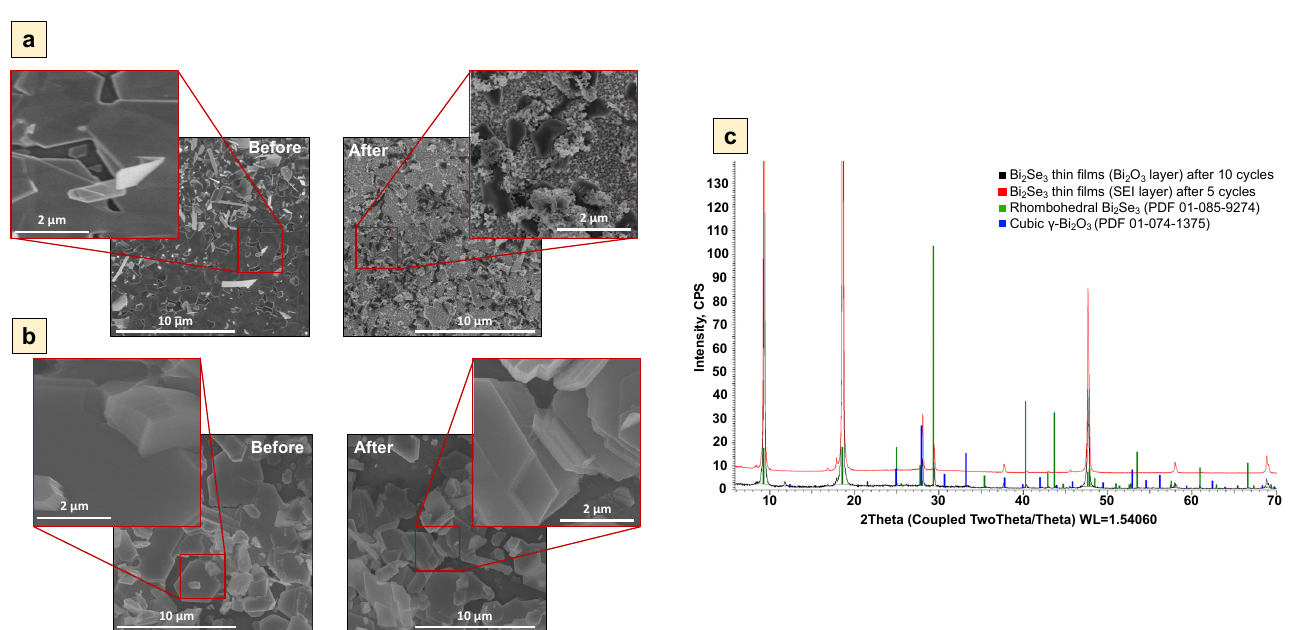
Figure 4. Scanning electron microscope images of Bi 2 Se 3 thin films in 5 M LiNO 3 before and after cyclic voltammetry measurements for: a —SEI layer after 5 cycles ( − 1.0 V ÷ 1.3 V), b —Bi 2 O 3 layer after 10 cycles ( − 1.0 V ÷ 0.5 V), c —XRD pattern of samples with SEI layer after 5 cycles ( − 1.0 V ÷ 1.3 V) and Bi 2 O 3 layer after 10 cycles ( − 1.0 V ÷ 0.5 V).